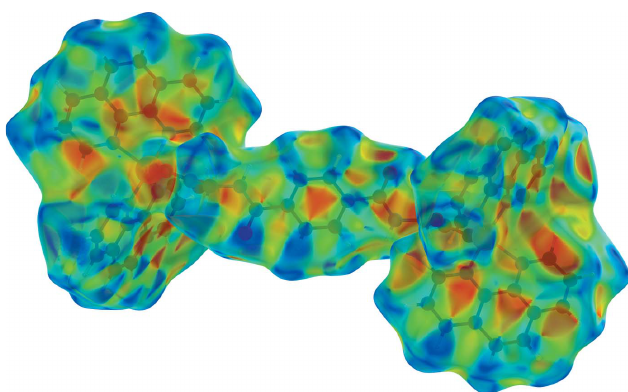
Figure 6 Hirshfeld surface drawn with transparency and mapped over the shape- index for the cationic complex. Red and blue triangles at the phenanthroline ligands and the N , N 0 -(1,4-phenylenedicarbon- yl)diglycinate ligand indicate the regions involved in (cid:2) – (cid:2) stacking interactions.